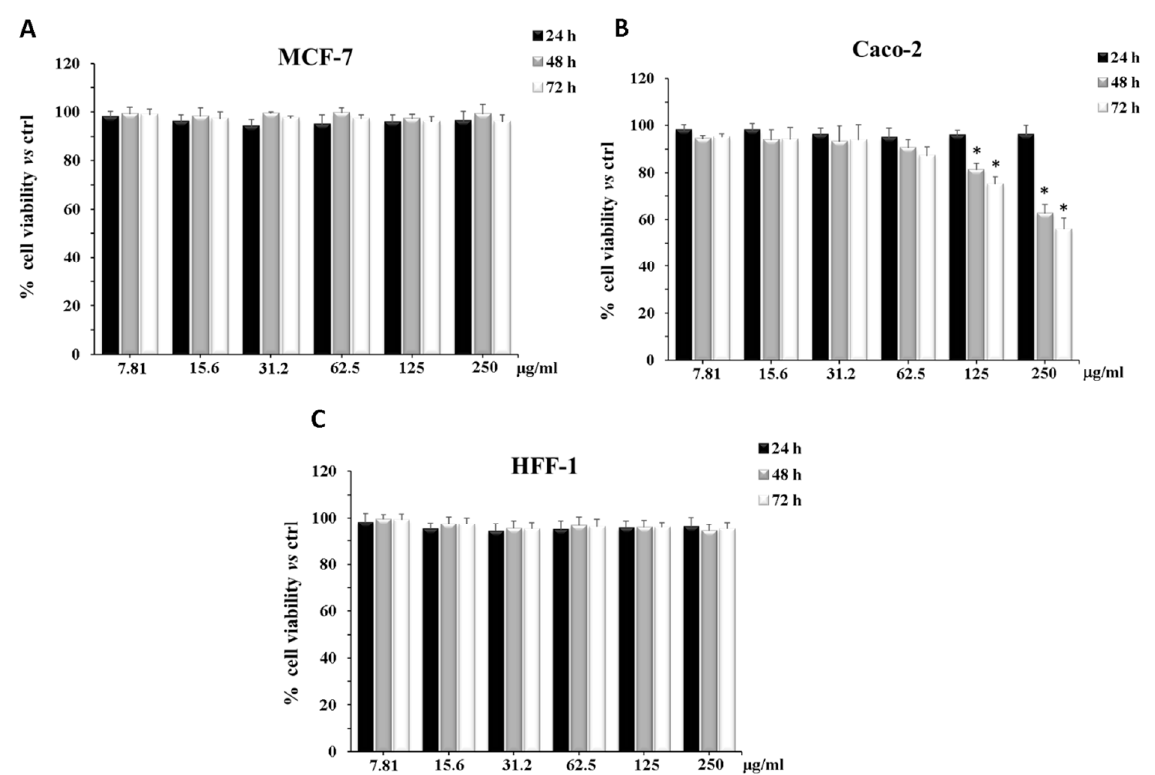
Figure 1. Cell viability of MCF-7 ( A ), Caco-2 ( B ), and HFF-1 ( C ) cells, untreated and treated for 24 h, 48 h, and 72 h with ethanolic extract of Juglans regia at different concentrations. Values are the mean ± SD of four experiments in triplicate. Statistically significant differences are indicated: * p < 0.05 versus control at the same incubation time.